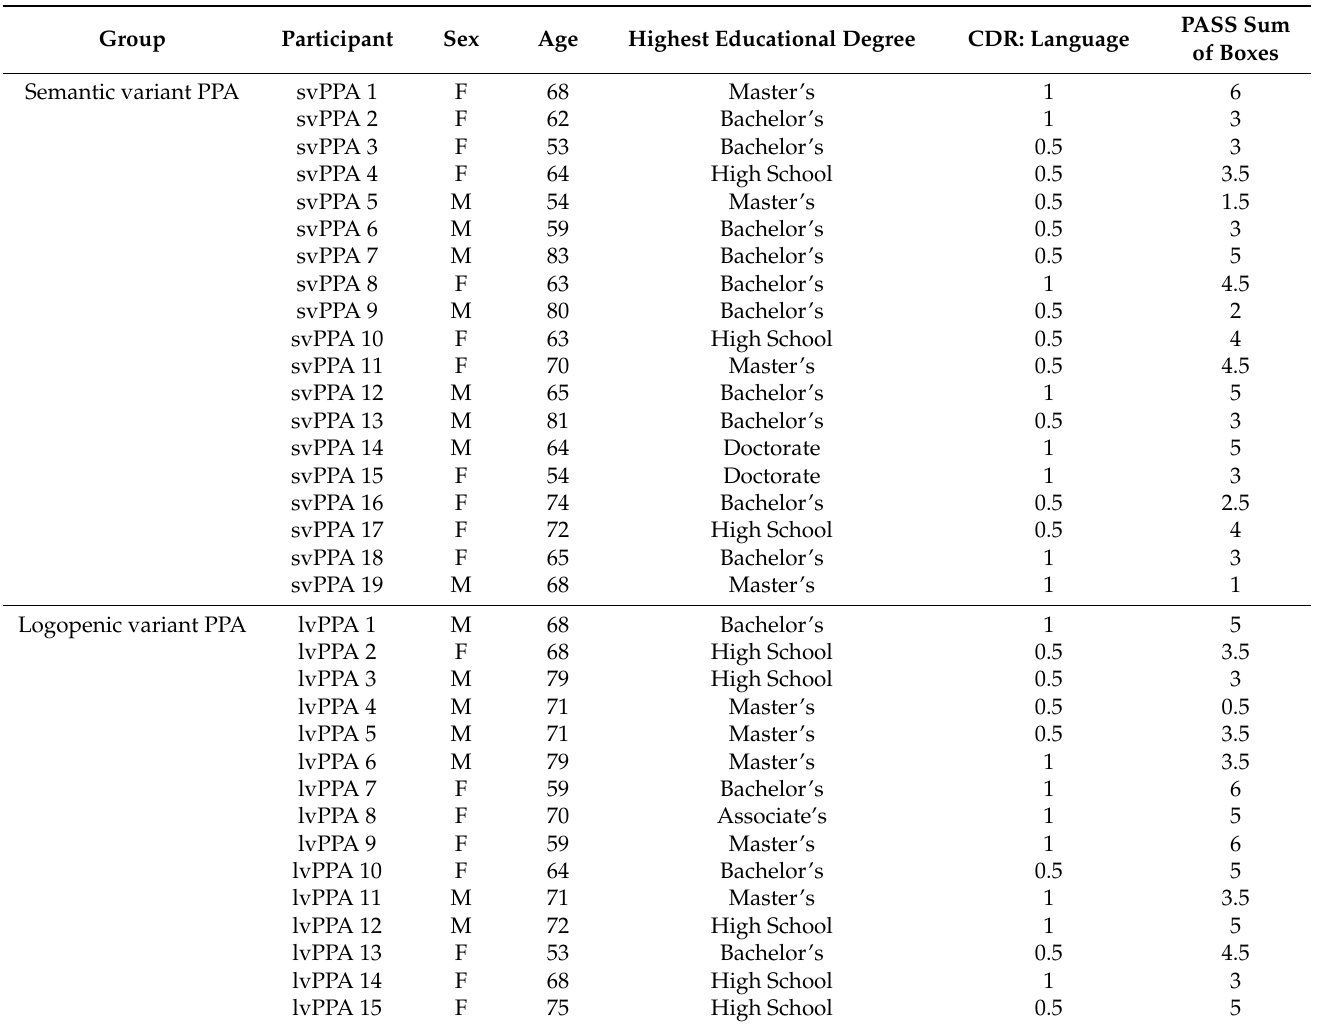
Table A1. Participant-specific demographic